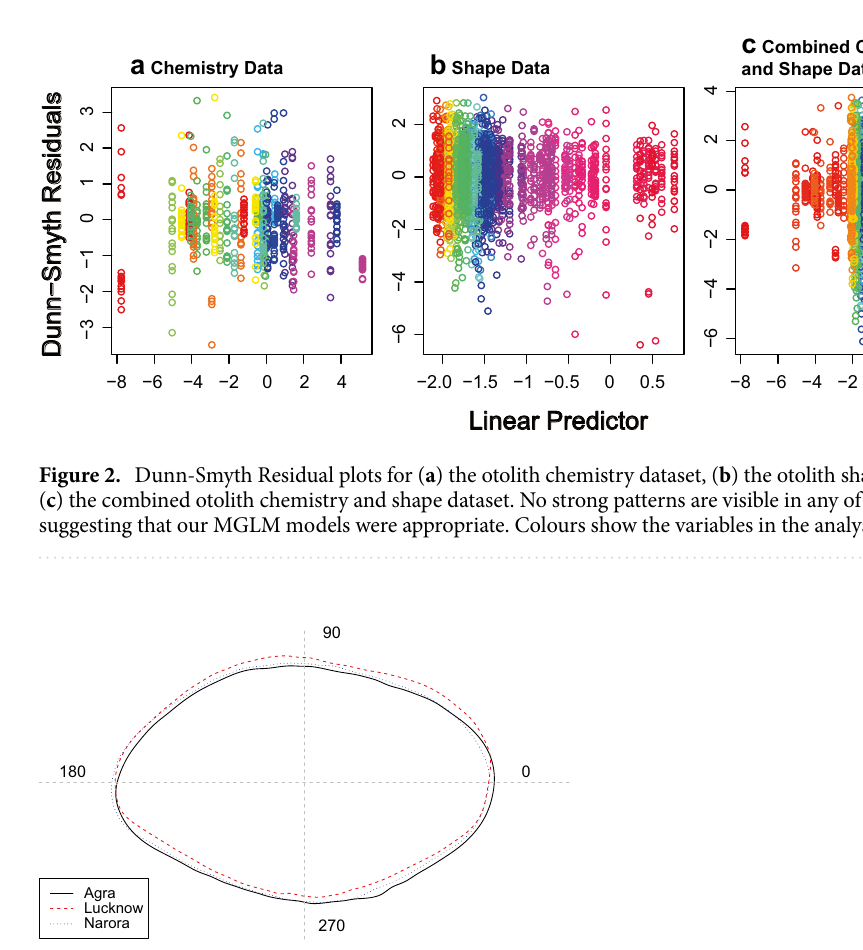
Figure 3. Mean otolith shape from the three sites using the ‘plotWaveletShape’ function in the ShapeR package 50 . The solid black line represents Agra, the dashed red line represents Lucknow and the dotted blue line represents Narora. The wavelet coefficients recreated over 99% of the variance in otolith